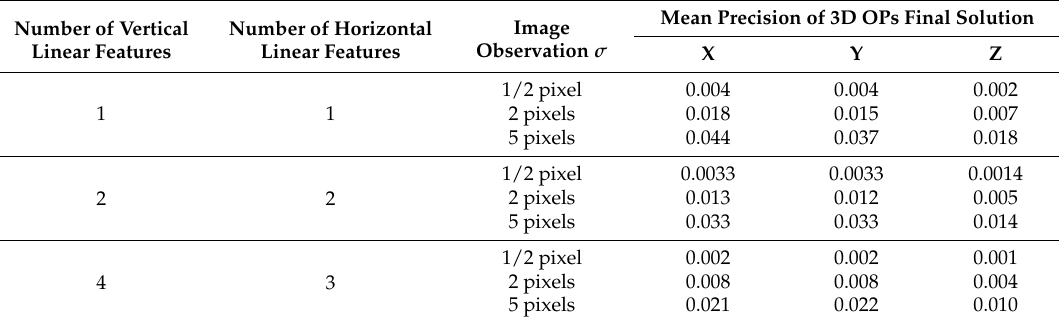
Table 7. The effect of changing number of constraints on 3D OPs final solution